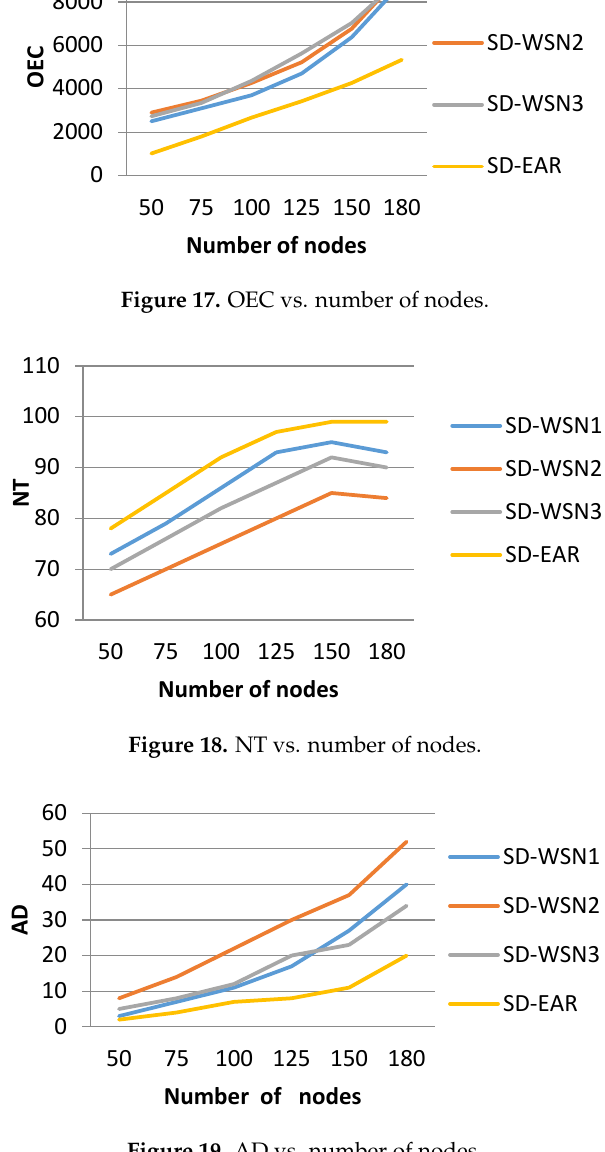
Figure 19. AD vs. number of